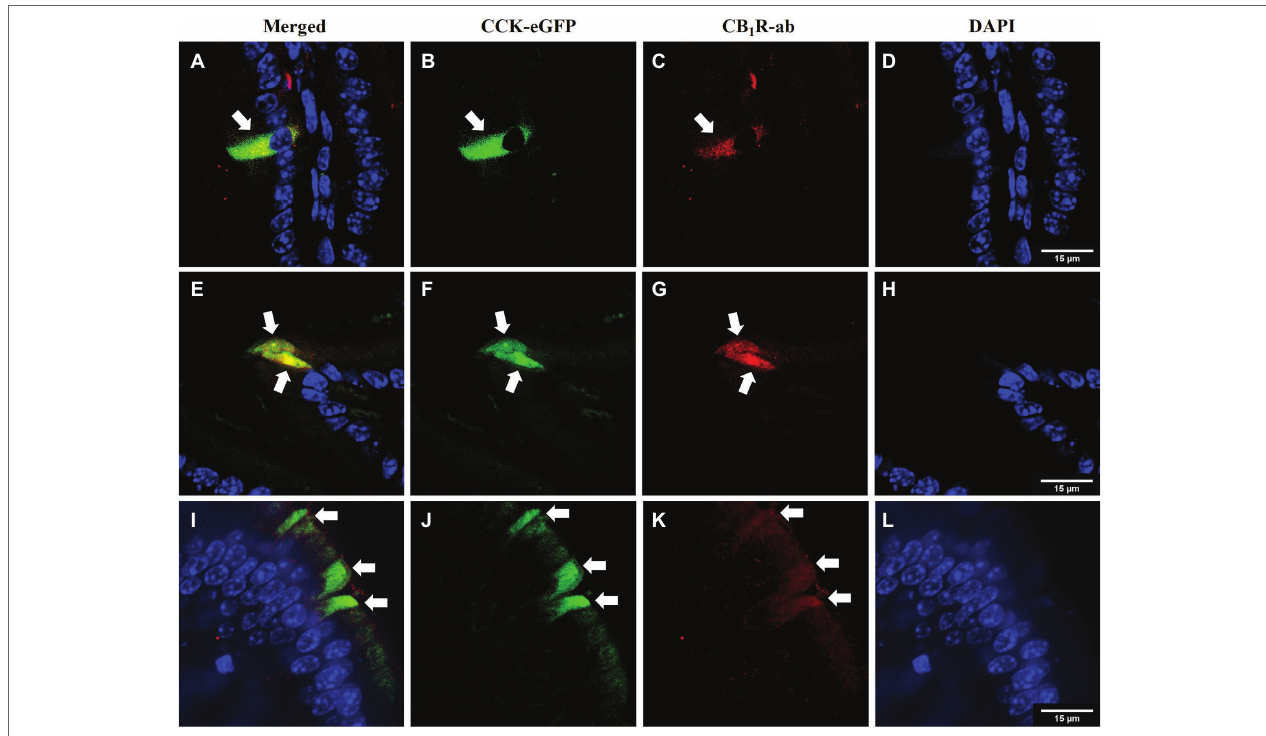
FIGURE 1 | CB1Rs co-localize with CCK-containing cells in the upper small-intestinal epithelium. Immunohistochemical detection of eGFP [CCK-eGFP (B, F, J) ] and CB 1 Rs [CB 1 R-ab (C, G, K) ] reveals co-localization [merge (A, E, I) ] in villi of intestinal epithelium. Arrows indicate separate enteroendocrine cells that contain immunoreactivity for CB 1 Rs that co-localize with CCK-eGFP cells. Representative images from three CCK-eGFP mice [DAPI stain (D,H,L)